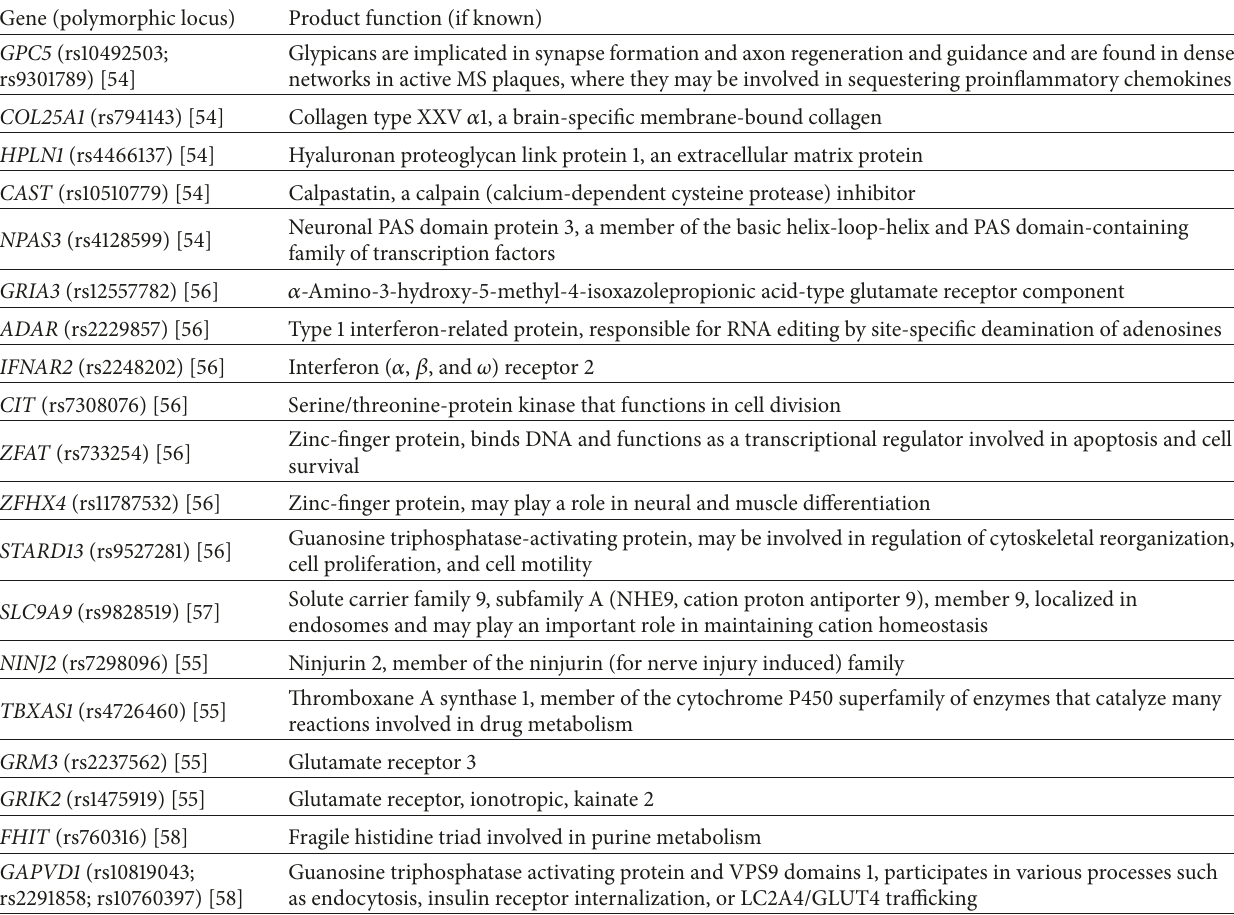
Table 5: Selected genes with polymorphisms showing significant association with response to interferon 𝛽 in patients with MS from genome- wide association studies.